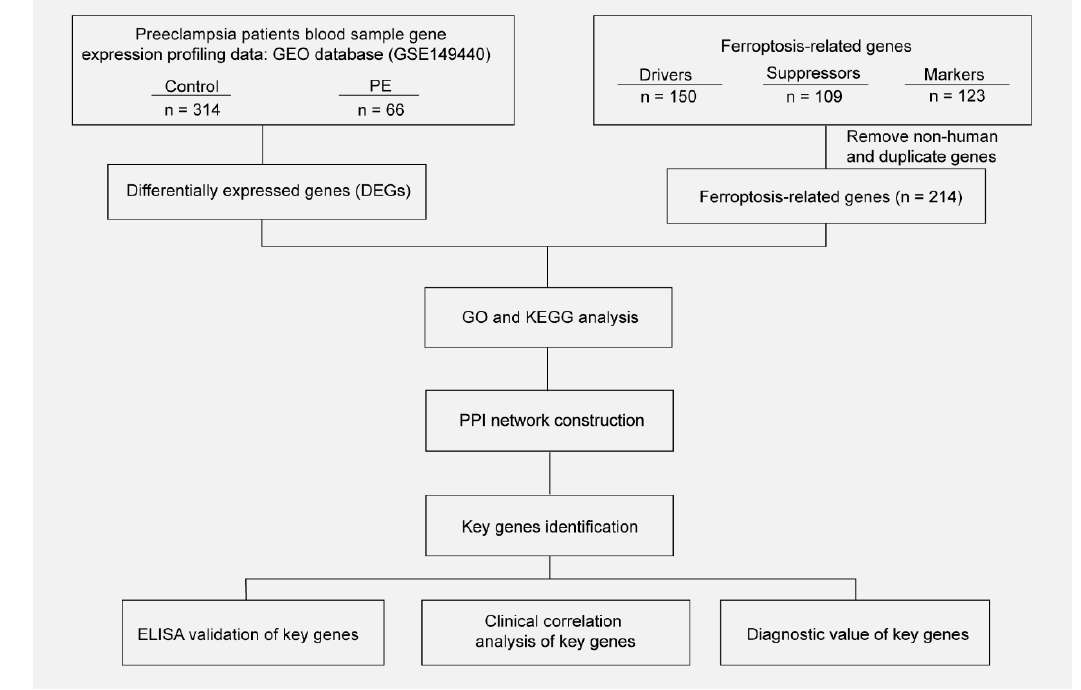
Figure 1. Workflow of searching hub genes in PE.